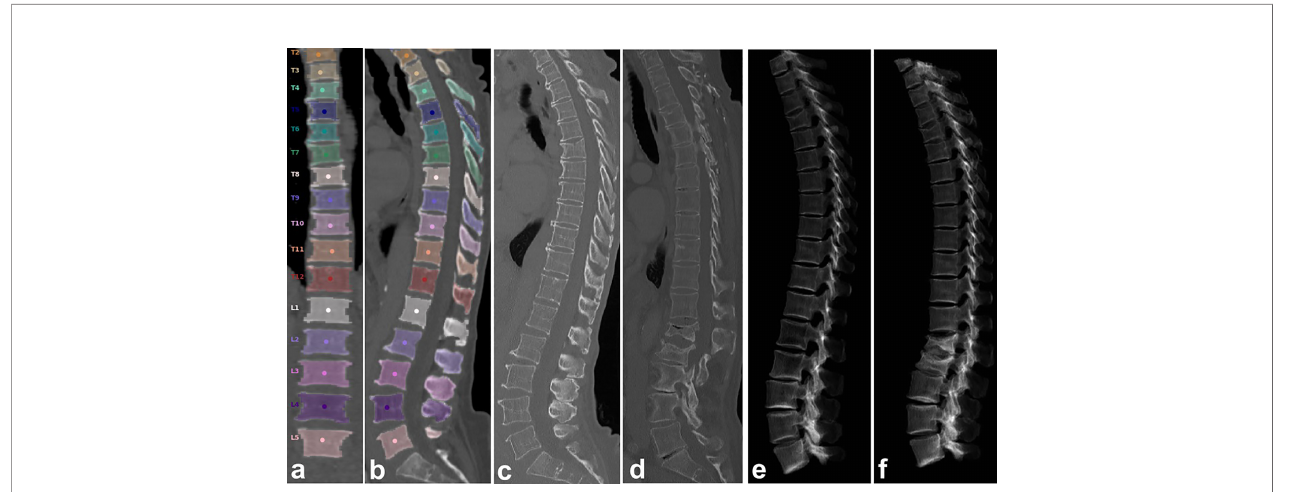
FIGURE 1 | Automated spine labeling and segmentation in coronal (A) and sagittal (B) view of a baseline CT of a 79-year-old female with trabecular vBMD (L1-L4) = 48.9 mg/cm³. (C, E) CT and virtual radiograph at baseline. (D, F) CT and virtual radiograph at follow-up after 8 months showing incident vertebral fractures of L1 and